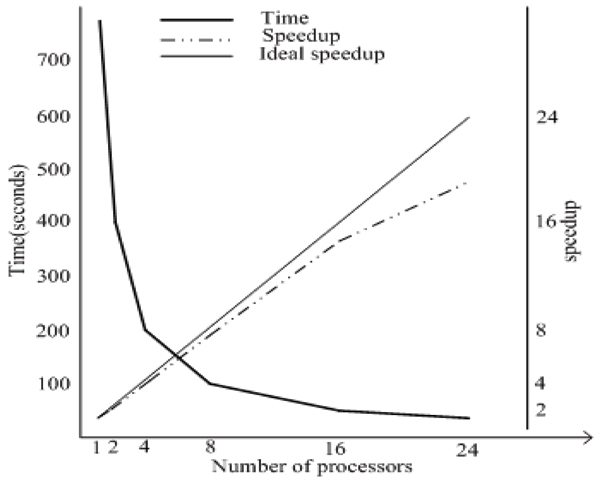
The execution time and speedup of PMC-SVM on sweetgum with Dataset 3 (14_Tumors).